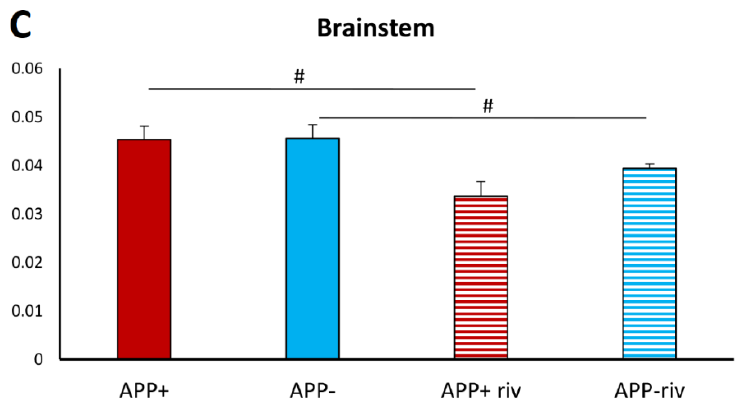
Figure 6. Acetylcholinesterase activity in hippocampus ( A ), cortex ( B ), and brainstem ( C ) in APP+ and APP − mice untreated (solid bars) and treated (striated bars) with rivastigmine. Data are expressed in mU min − 1 mg − 1 and presented as mean ± SEM. # p < 0.05, ## p < 0.01, ### p < 0.01 (n = 6 per each bar).